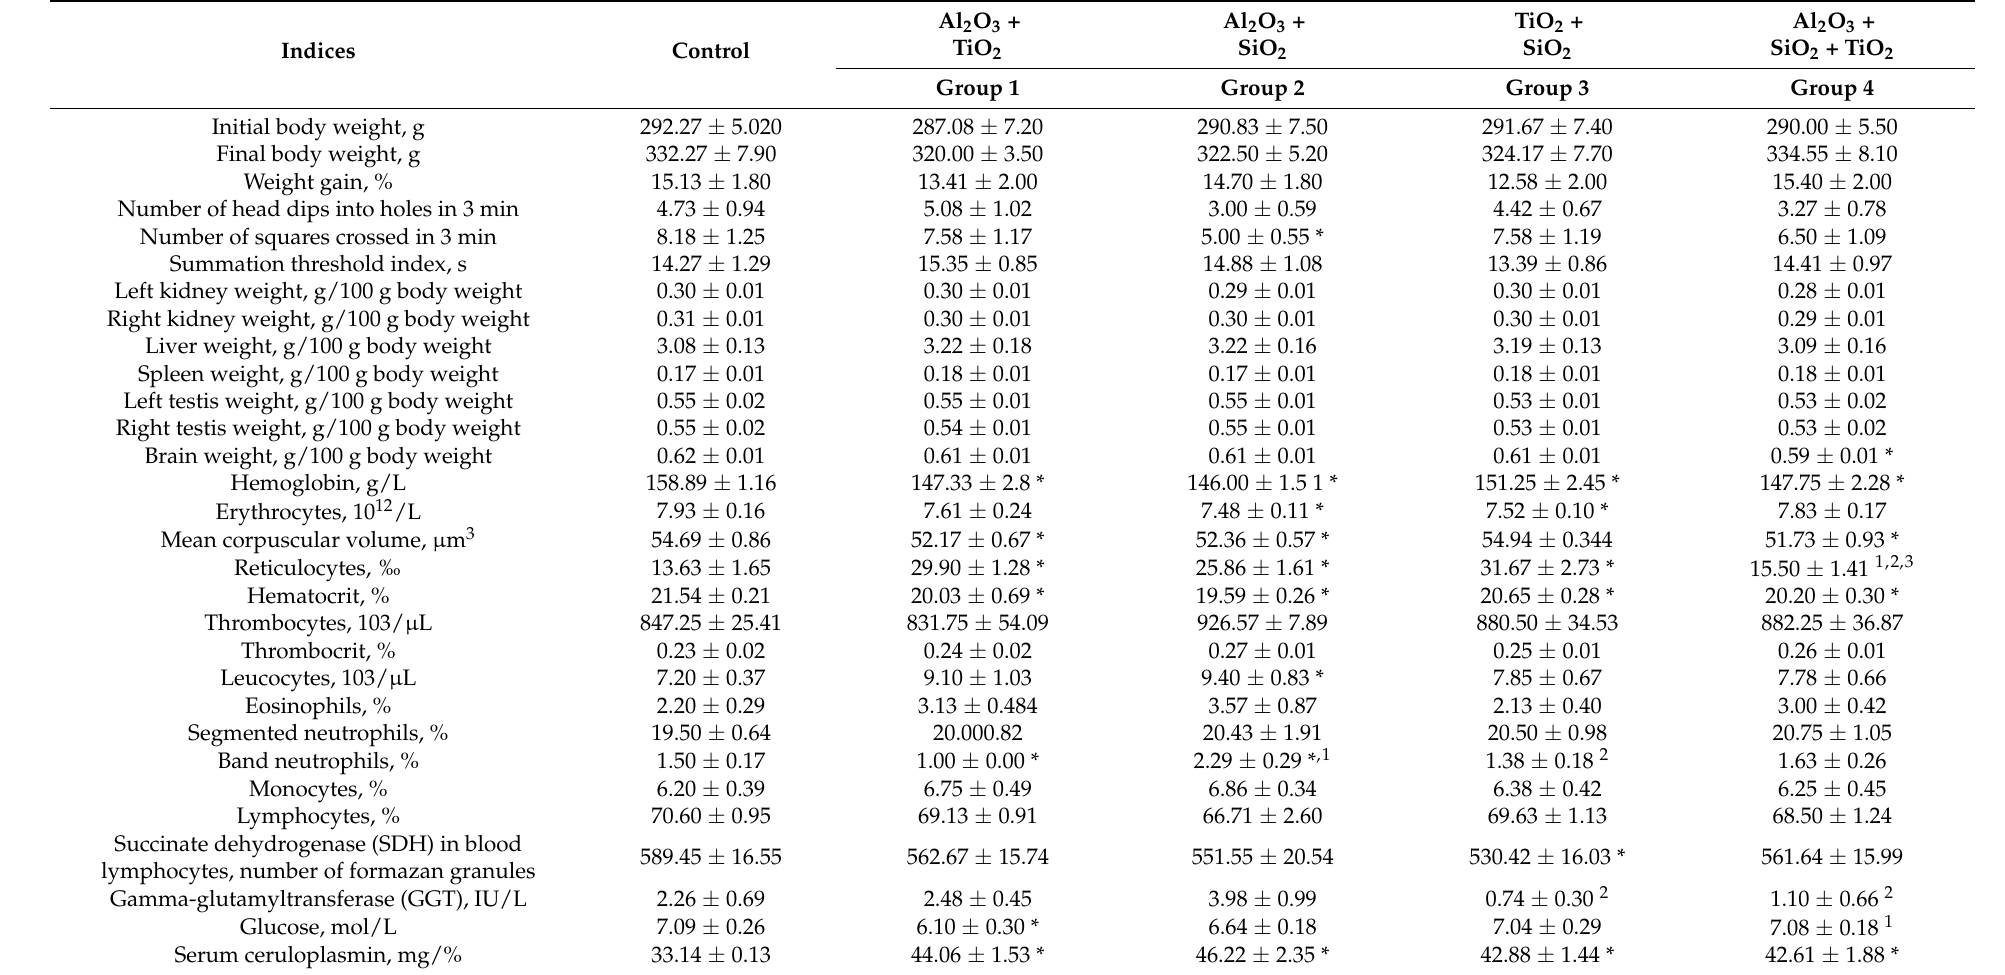
Table 1. Some functional indices of the rat organism following 18 intraperitoneal injections of MeO NPs in binary and ternary combinations administered during six weeks (X ±